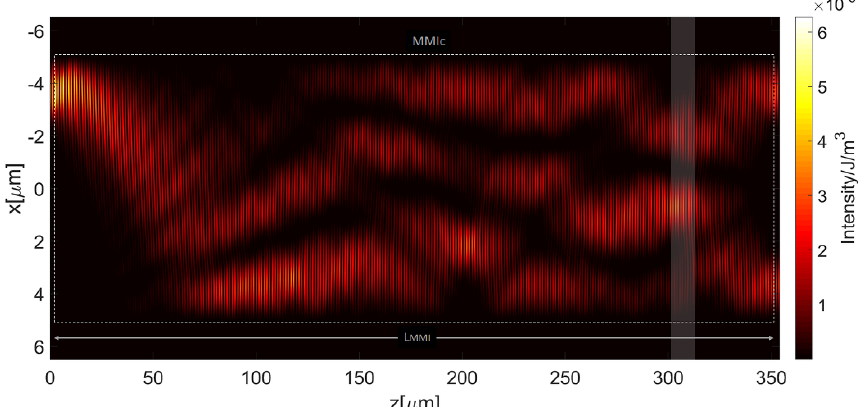
Figure 5. The interference pattern created by multimode interference effect in the ARROW-based multimode interference coupler (MMI c ). Dotted line indicates the waveguide wall of the MMI c. Hence, the MMI c has been simulated by inserting a 14 μ m wide microfluidic channel which is located at z = 305 μ m, where the field intensity decreases substantially near the ARROW waveguide wall. Numerical results give, in this case, transmitted powers 𝑃 (cid:2869) = 0.4872 and 𝑃 = 0.4825 . These values are very close to the ones calculated for the unper- (cid:2870)